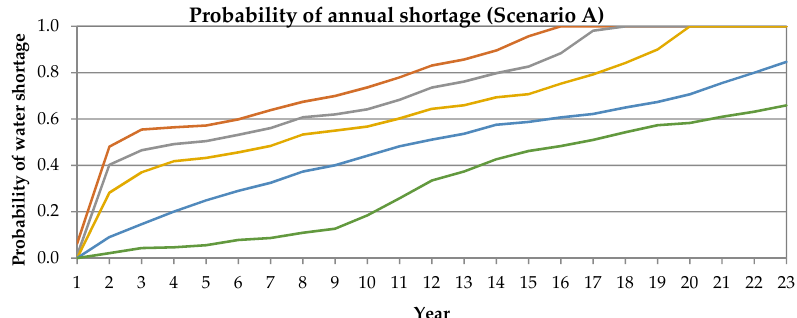
Figure 5. Expected probability of annual water shortages of different magnitudes in Great Gaborone for each year in Scenario A.